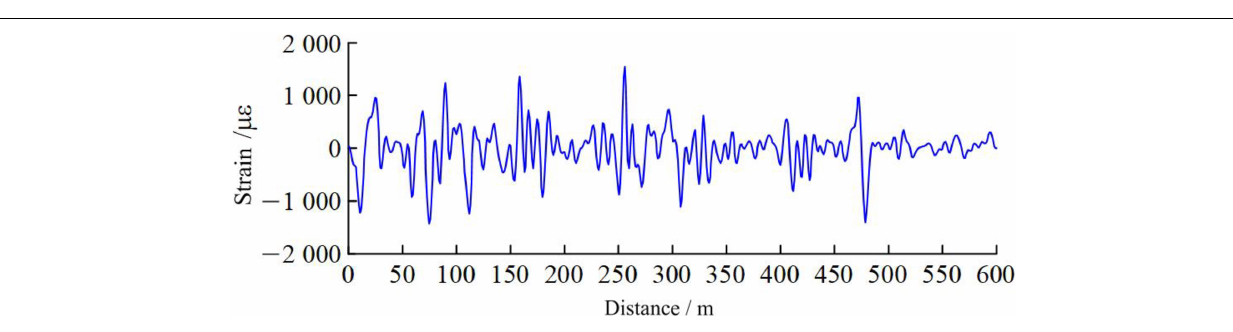
FIGURE 10 | Butterworth low-pass filters of the optical fiber data difference between 12.01.2019 and 07.01.2020.